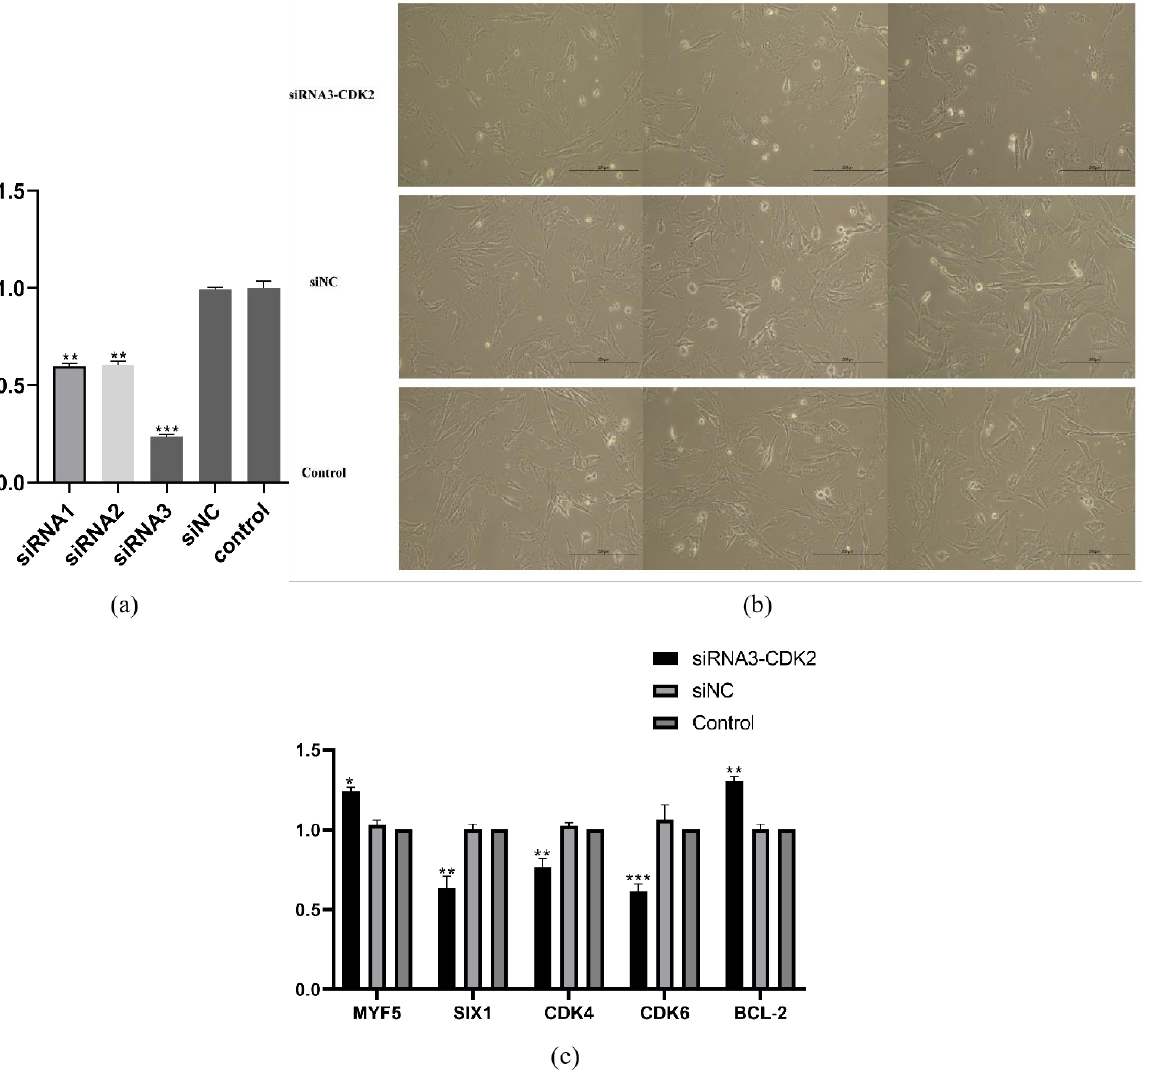
Figure 7. CDK2 knockdown expression affects the cell cycle of sheep primary embryonic my- oblasts. ( a ) Comparing the transfection effect of three siRNAs, ( b ) the phenotypes of the sheep primary embryonic myoblasts transfected with siRNA3- CDK2, siNC, and control were analyzed, and ( c ) the qRT-PCR results of the related genes after the siRNA3- CDK2 knockdown, muscle growth and development, cell cycle, and apoptosis-related genes, p < 0.05 (*), p < 0.01 (**), or p < 0.001